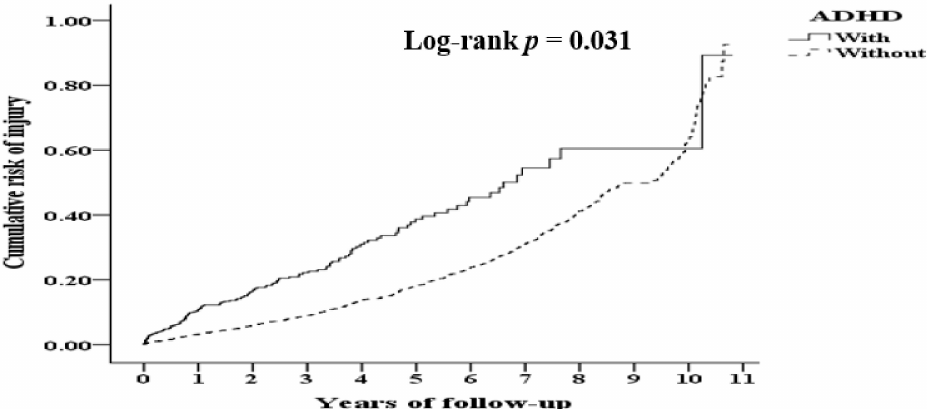
Figure 2. Kaplan–Meier for cumulative risk of injury among minors under the age of 18 stratified by ADHD with log-rank test. Table 9. Distribution of injury-hospitalized children stratified by ADHD status, season, and cause of